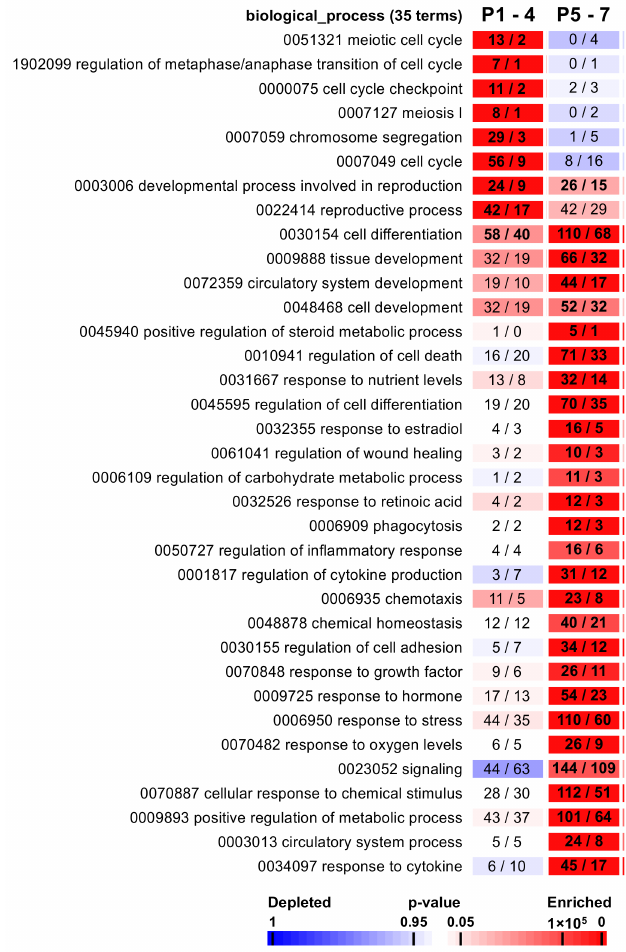
Figure 4. Gene ontology enrichment in cultured testicular tissues. Each cluster is matched with a selection of enriched GO terms from the ontologies “biological process” and “cellular component”. Significantly enriched “biological process” terms and their identification numbers are given, followed by the total number of genes associated with the term and the numbers of genes observed vs. expected by chance. Significant GO terms for each pattern were highlighted with bold values. A color code indicates overrepresentation (red) and underrepresentation (blue) as indicated in the p value scale